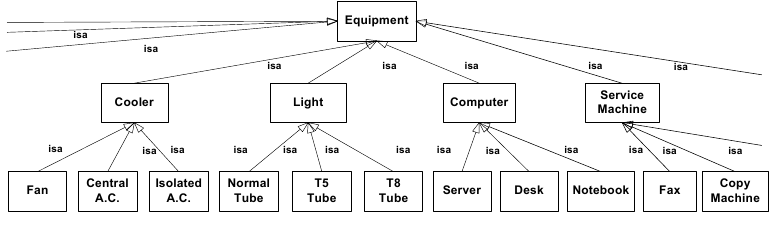
Figure 3. Part of energy-saving ontology.